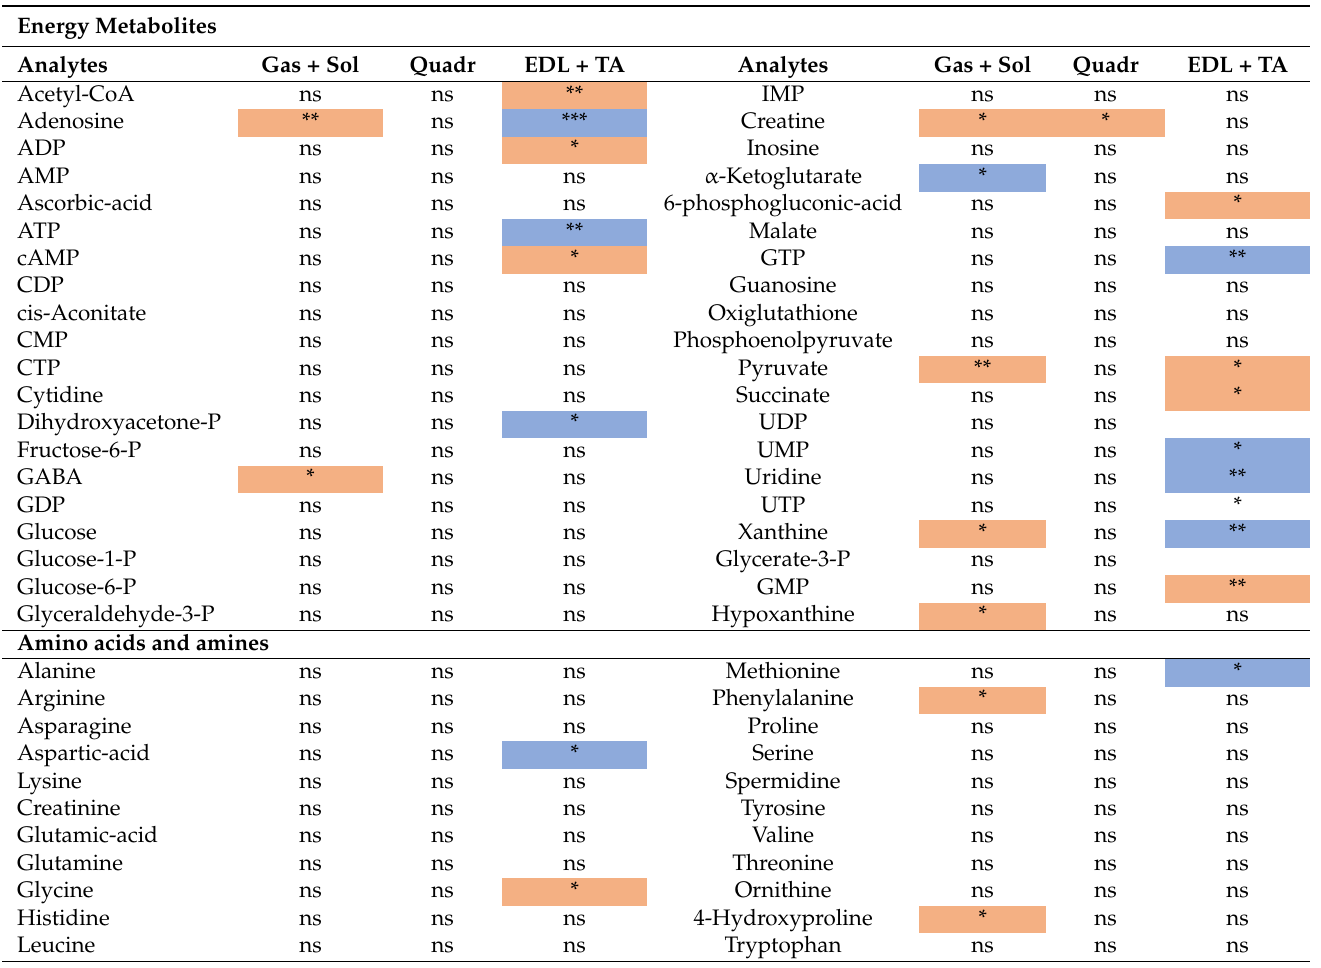
Table 2. The effect of sample collection speed on stability of energy metabolites, amino acids, and amines in different muscle types (n = 3).